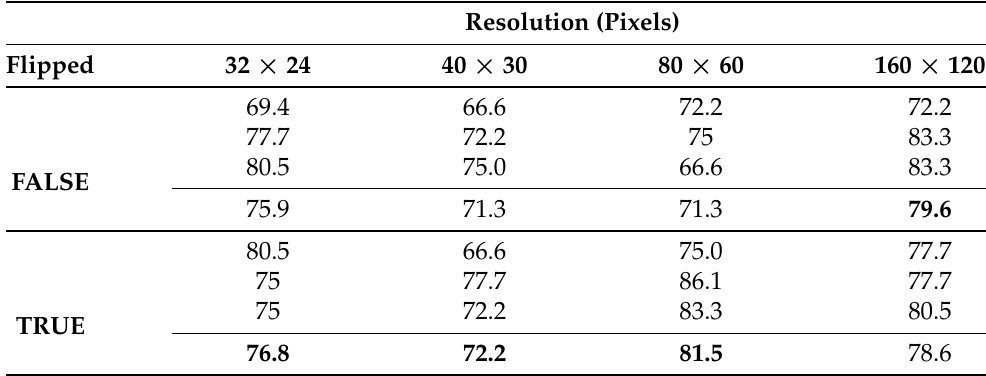
Table 6. Accuracy (%) of the models trained with the eight different configurations from experiment P04 (using 70% of the dataset for training). Each cell presents the accuracy of the three independent models per configuration and its average. The best results per resolution are highlighted in